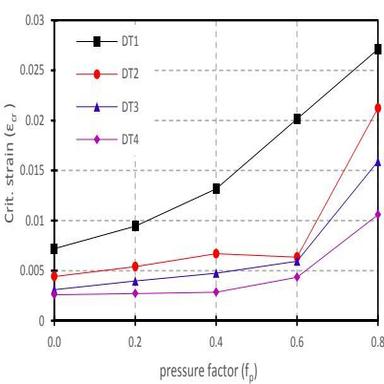
Plot of εcr vs. fp for YPT X60 pipe (YPL = 2.0).